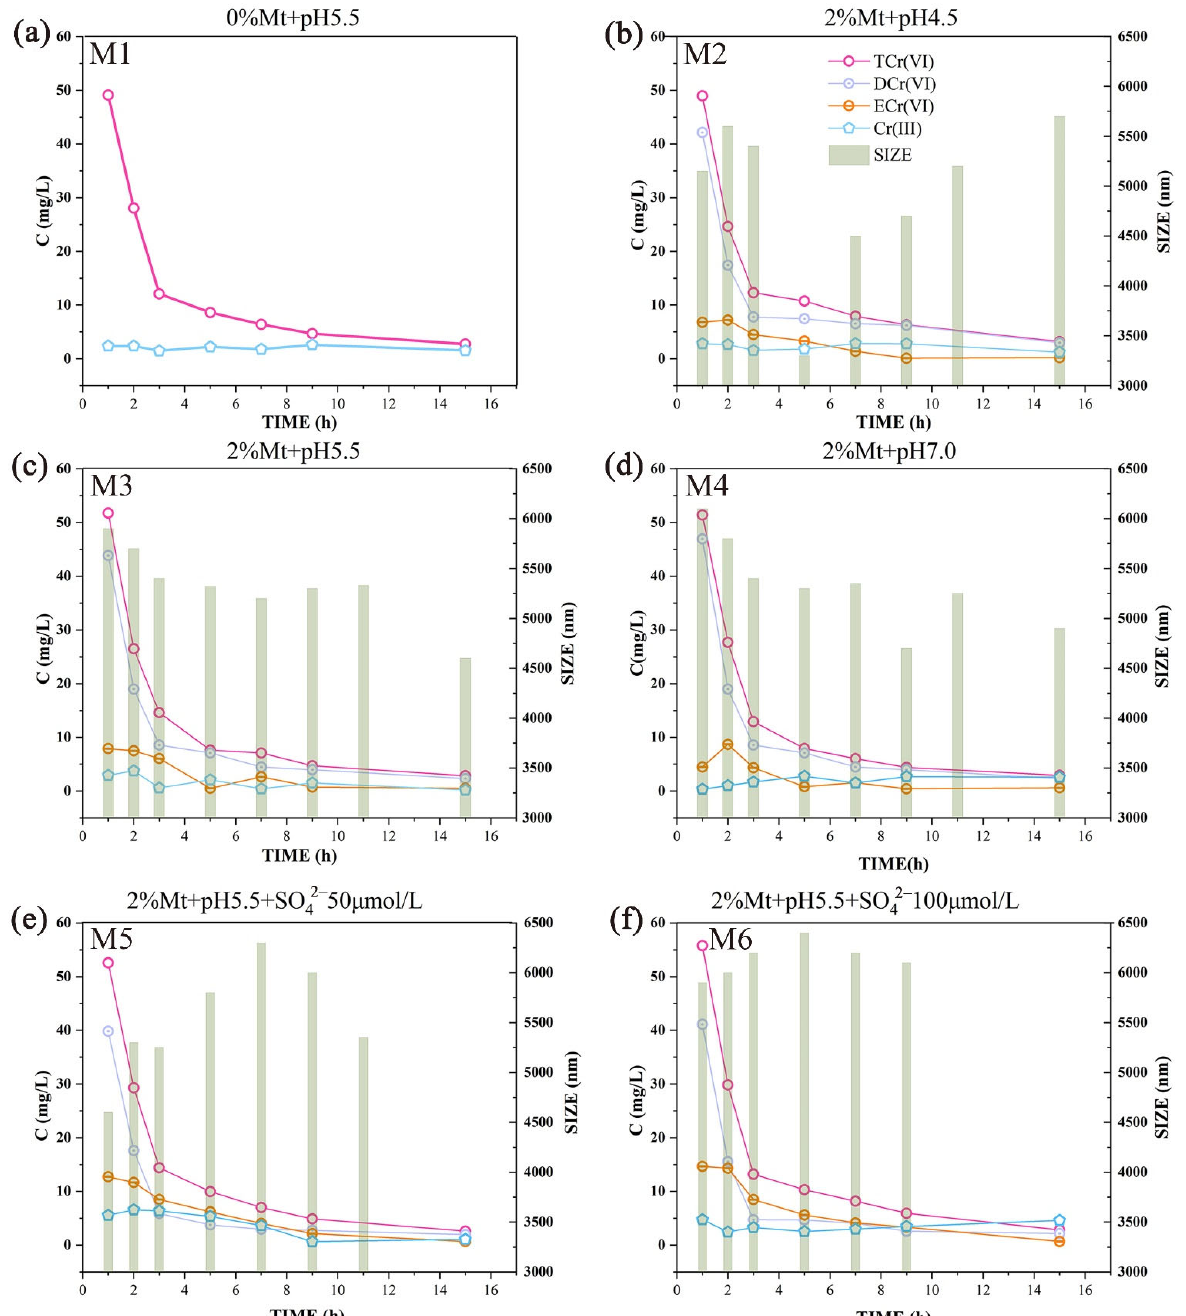
Figure 4. Total Cr (VI) (TCr (VI)), dissolved Cr (VI) (DCr (VI)), colloidal Cr (VI) (ECr (VI)), Cr